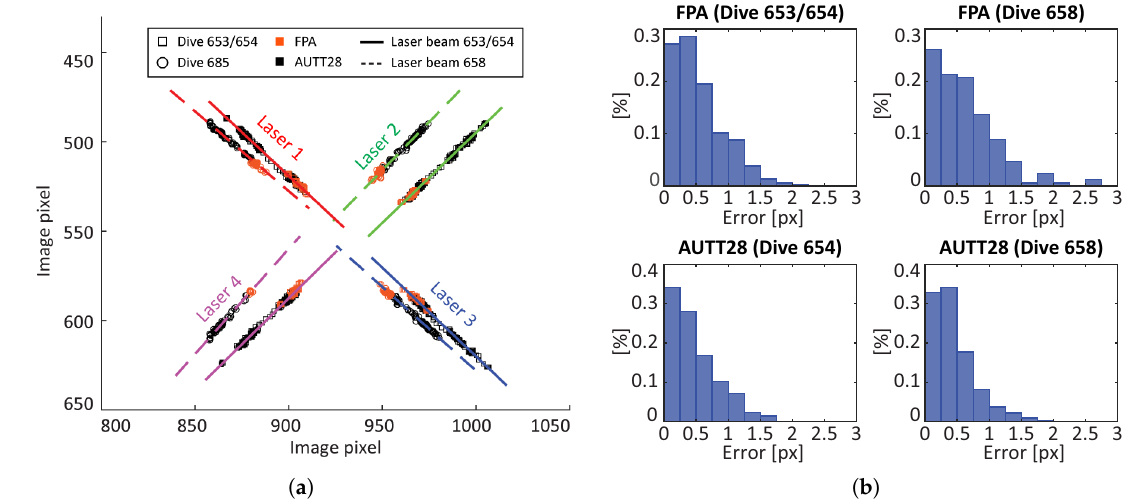
Figure 17. ( a ) Calibration results for dives 653/654 and 658. Solid and dotted lines represent the projections of estimated laser beams on the image plane, while projected laser intersections with the scene are depicted as squares/circles. ( b ) Histogram of perpendicular distances between the projected laser beams and projected laser intersections for the two datasets and dives.